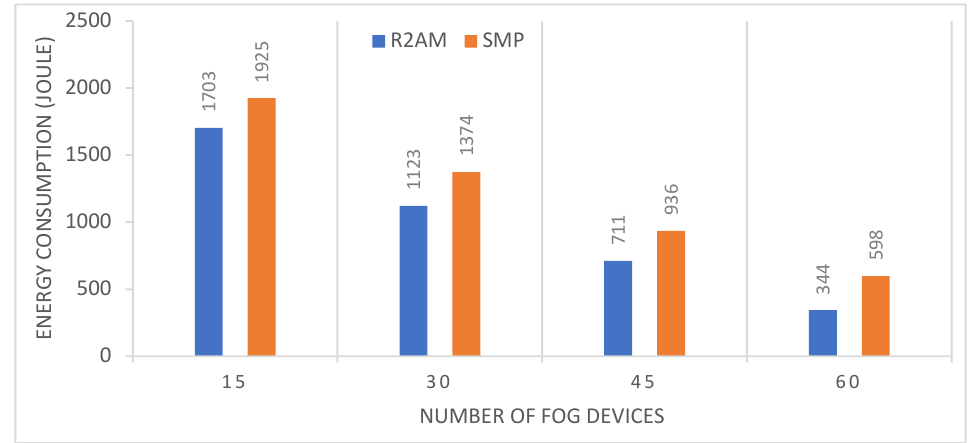
Figure 3. Energy Consumption comparison of proposed and existing strategies.